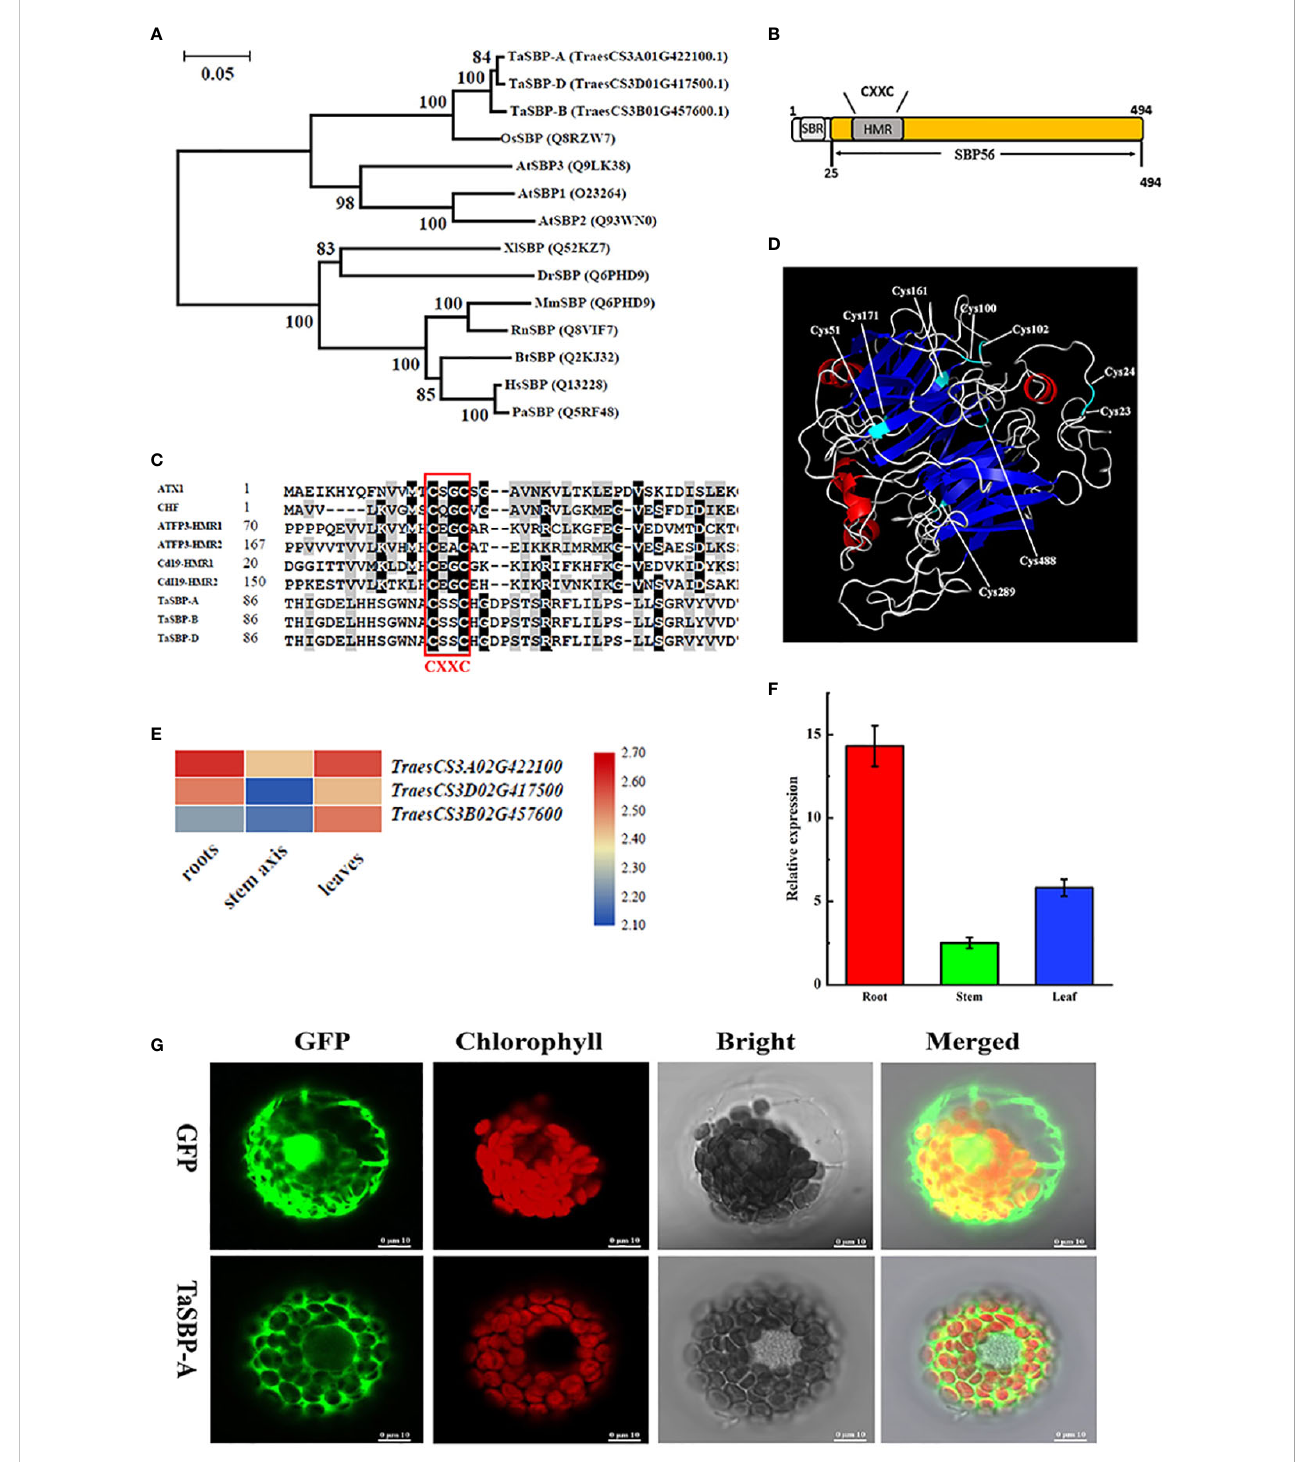
FIGURE 1 Phylogenetics and structural characterization of wheat TaSBPs. (A) Phylogenetic relationships between TaSBP-A/B/D protein and other SBPs of various species. (B) Simpli fi ed illustration of TaSBP protein structure. One putative metal binding region (HMR) and one Selenium-binding region (SBR) are shown. (C) Protein sequences containing the CXXC-type metal binding domain were acquired from GenBank. Accession numbers include ATX1 (P38636), CHF (AAC33510), ATFP3 (AAD09507) and Cd19 (AAM64219.1). The core sequence of the metal binding region is CXXC (here C represents cysteine and X represents any amino acid). (D) 3-D structure of TaSBP-A based on the structure of S. tokodaii (SMTL ID: 2ece.1). (E) The heat map of TaSBP ’ s expression in the root, stem and leaf of wheat seedings. (F) The expression of TaSBP-A in different organs of Chinese Spring at the three-leaf stage. (G) Subcellular distribution of the 35S-TaSBP-GFP fusion proteins in wheat protoplasts as shown by confocal laser scanning microscope. The red represents the chloroplast fl uorescence and the green indicates the GFP fl